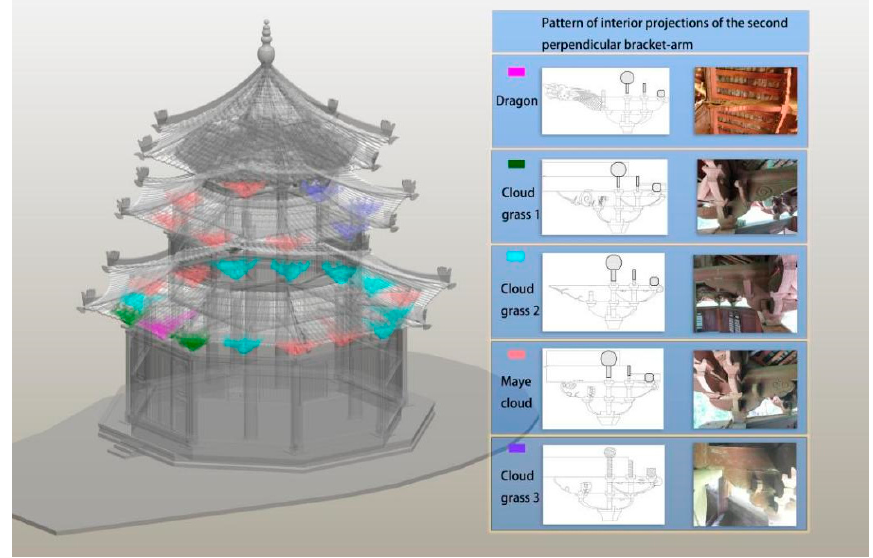
Figure 21. The spatial distribution of the pattern of interior projections of the second perpendicular bracket ‐ arm.